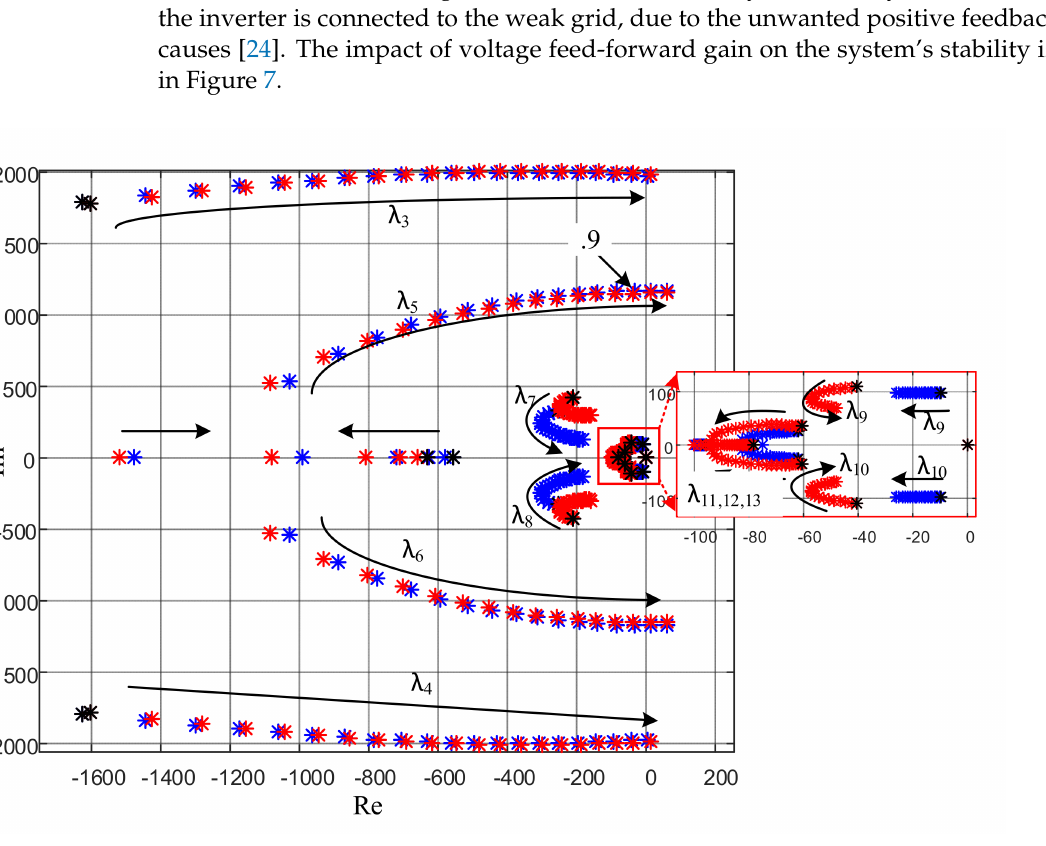
Figure 7. Sensitivity of system eigenvalues under variation of voltage feed-forward